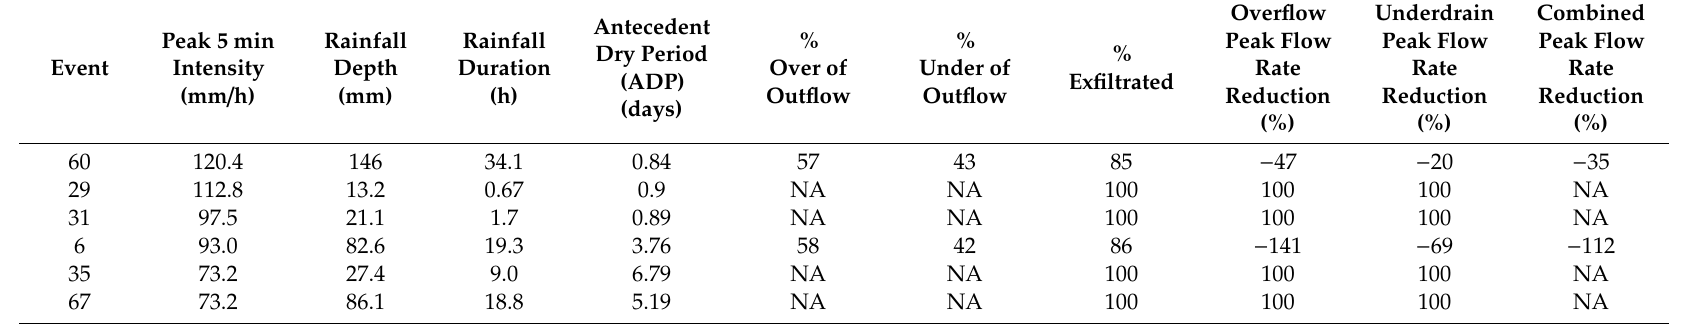
Table 6. Hydrologic performance of the largest peak 5 minute rainfall intensity events.